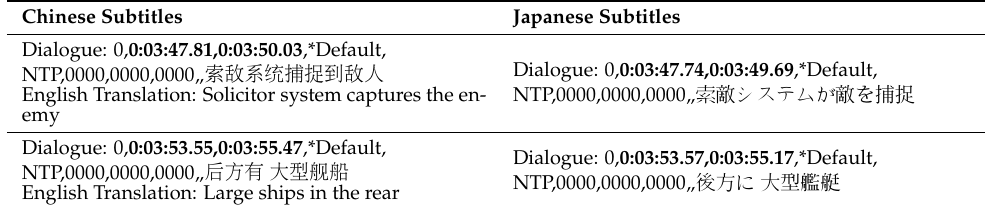
Table 5. Examples of timeline errors. The timeline has been